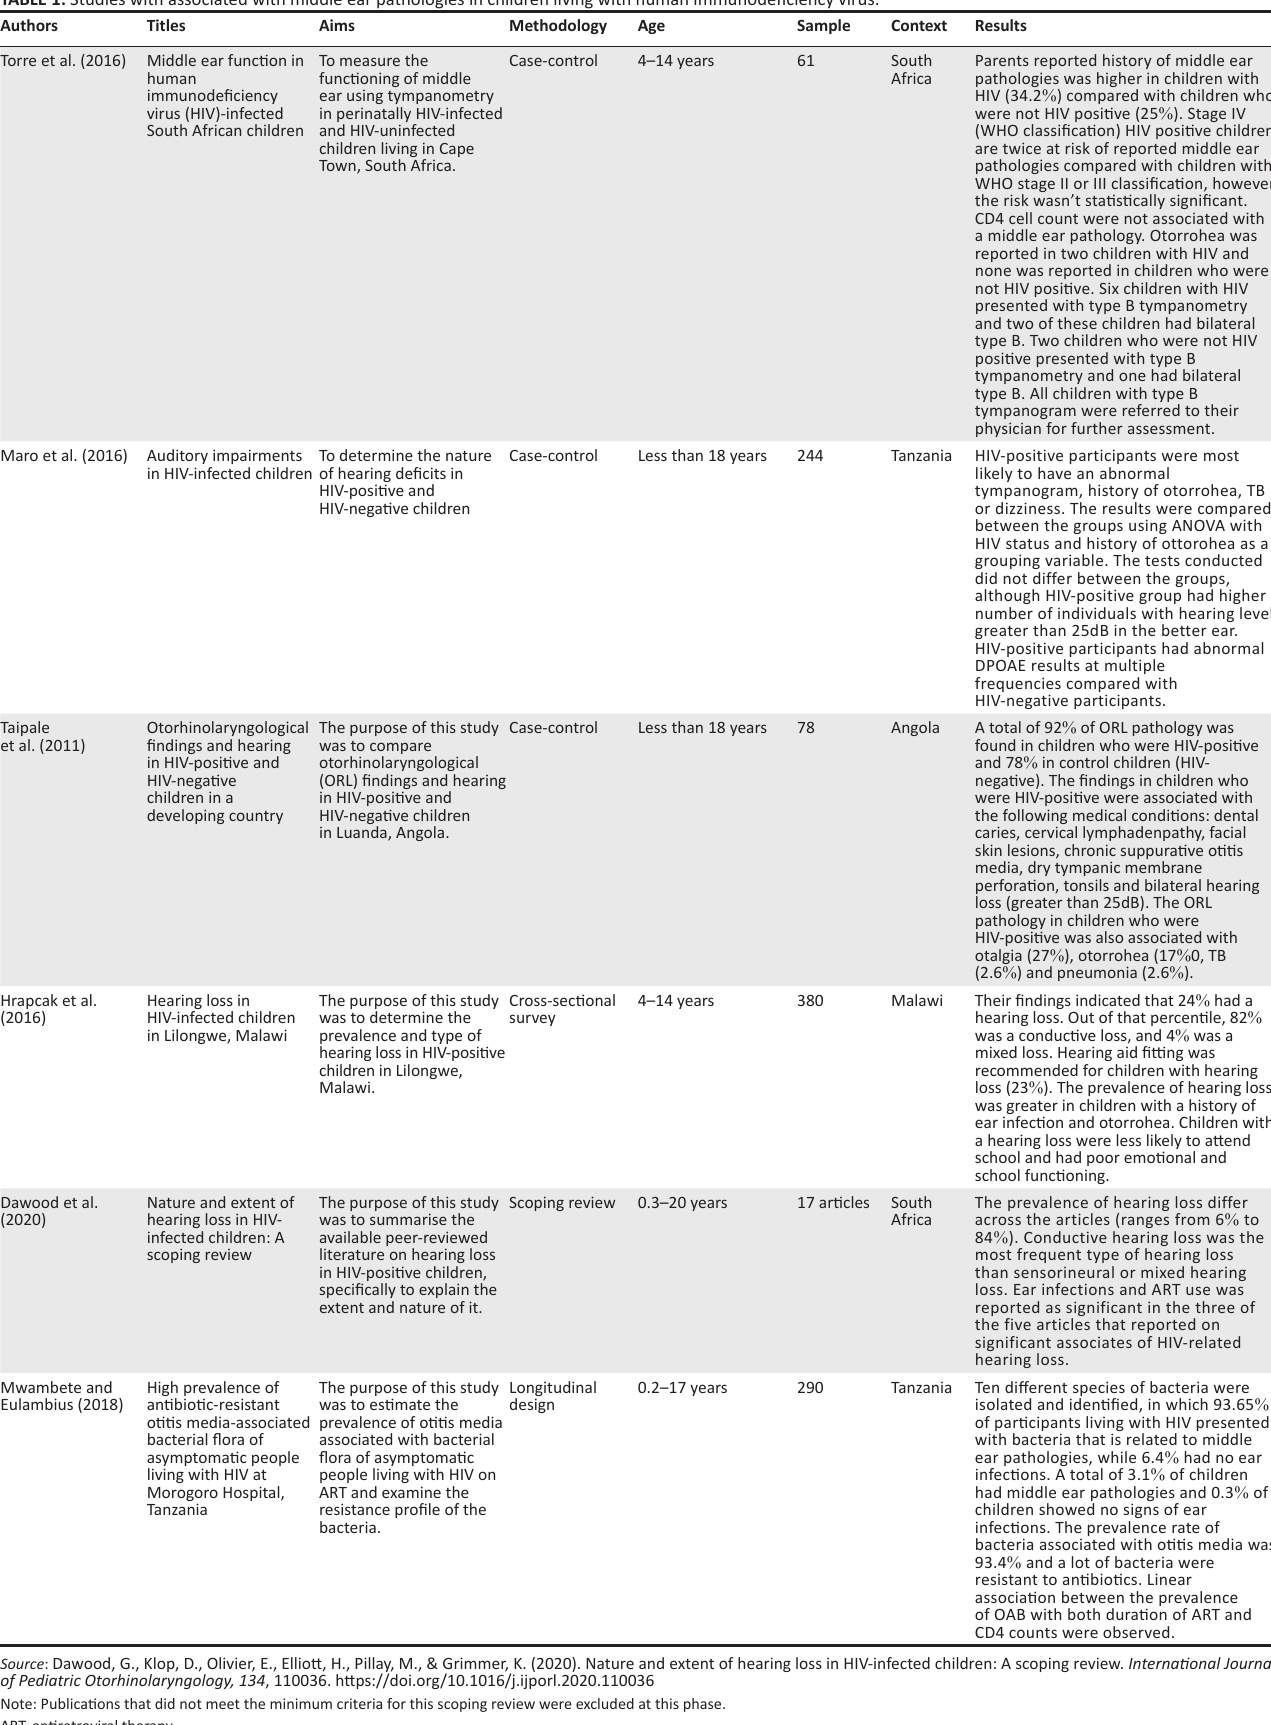
TABLE 1: Studies with associated with middle ear pathologies in children living with human immunodeficiency virus.